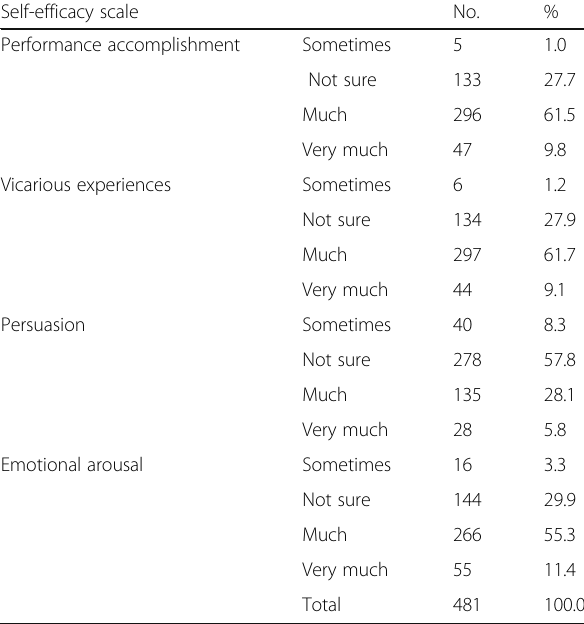
Table 2 Self-efficacy among